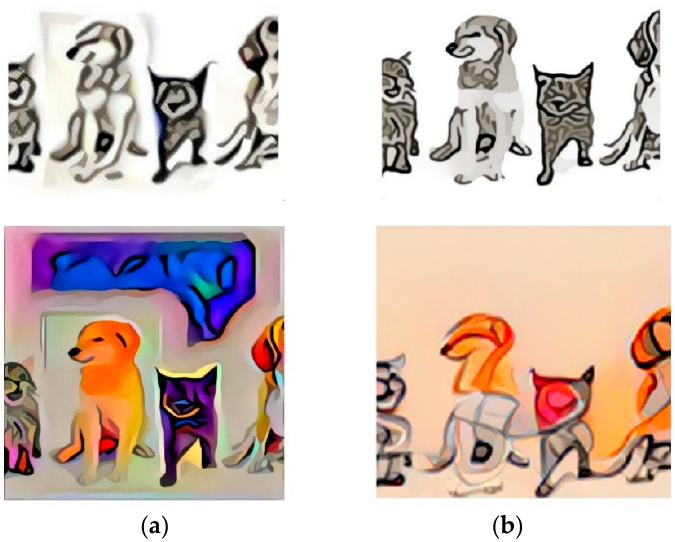
Figure A2. Comparison of results between the default NST implementation ( a ) and STROTTS ( b ).